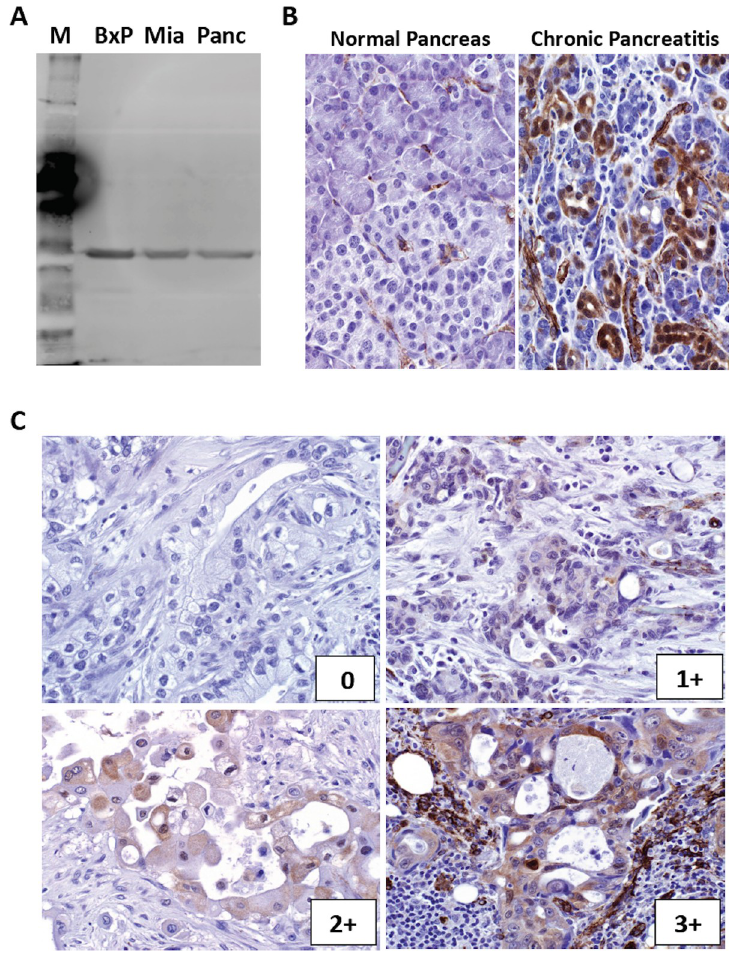
Fig 1. NAMPT expression in PDA. (A) Immunoblot analysis for NAMPT in human pancreatic cancer cell lines (BxP: BxPC3, Mia: MiaPaCa2, Pan: Panc1). Note the detection of a single band for each cell line. ( B) Immunohistochemical staining of NAMPT in normal pancreas (left panel) and chronic pancreatitis (right panel). Note NAMPT detection (brown) in areas of chronic pancreatitis. ( C) Immunohistochemical staining of NAMPT with difference scores: 0 (top left panel), 1+ (top right panel), 2+ (bottom left panel), 3+ (bottom right panel).